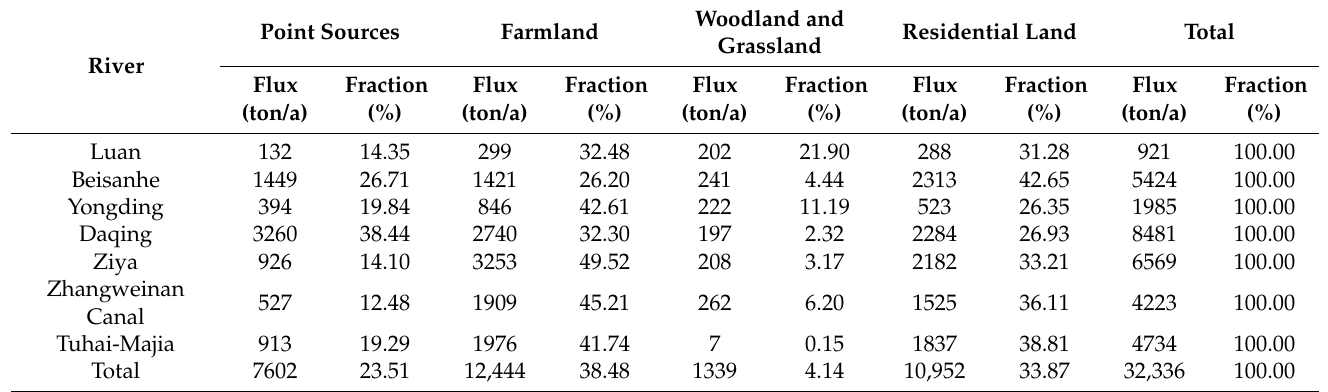
Table 6. Nutrient sources’ fluxes and fractions of main rivers in